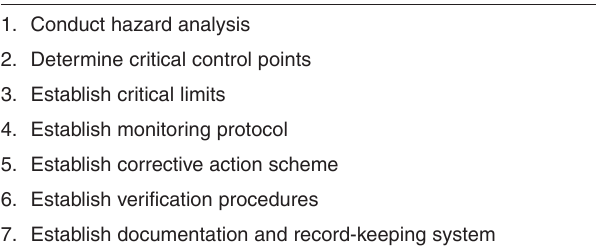
TABLE 2 Seven steps of the Hazard Analysis Critical